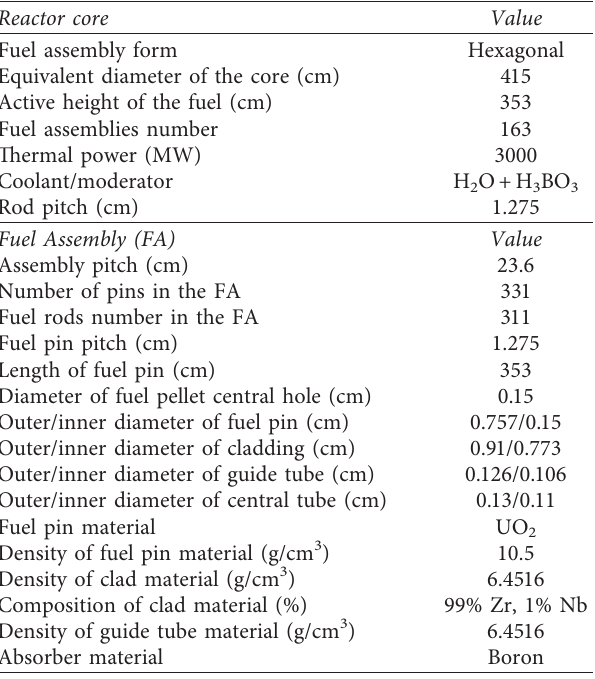
Table 1: Reactor core and fuel assembly design data